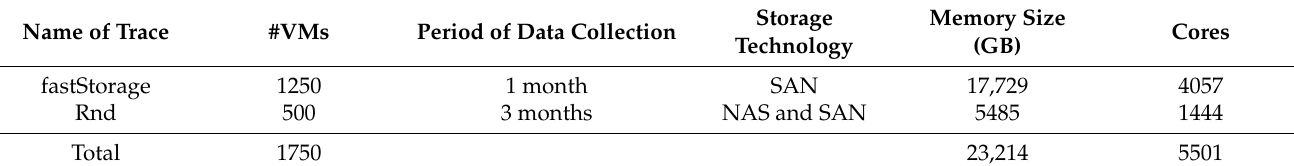
Table 1. Workload traces of the Bitbrains cloud